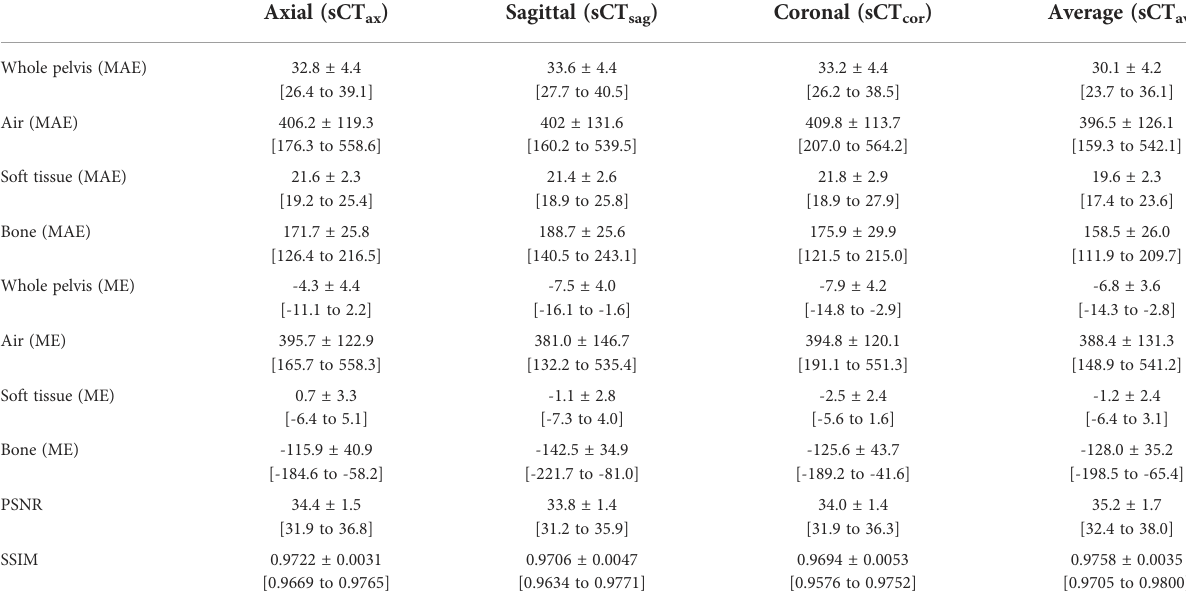
TABLE 2 MAEs and MEs for whole pelvis and individual segments (air, soft tissue and bone) and PSNRs and SSIMs for whole pelvis.